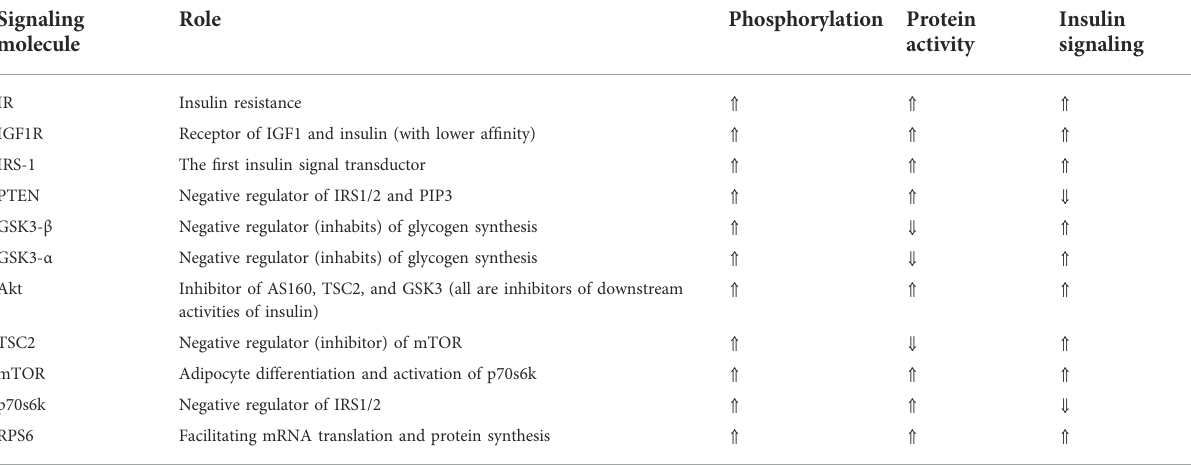
TABLE 1 Insulin signaling proteins and the role of their activation (phosphorylation) in insulin signaling cascade, arranged according to the physiological order of signal transduction from outside to inside the cell. Signaling